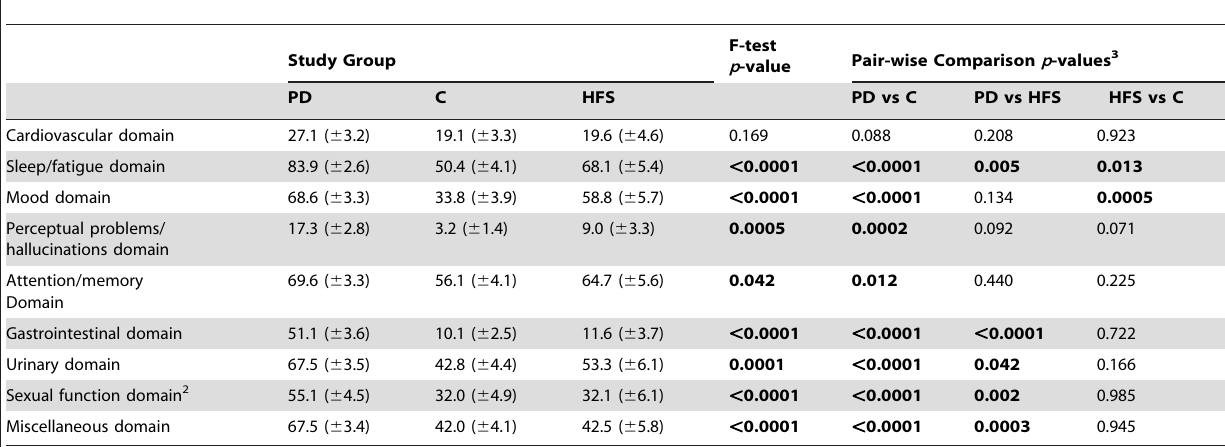
Table 3. Comparisons of estimated prevalence 1 (%) by NMSS